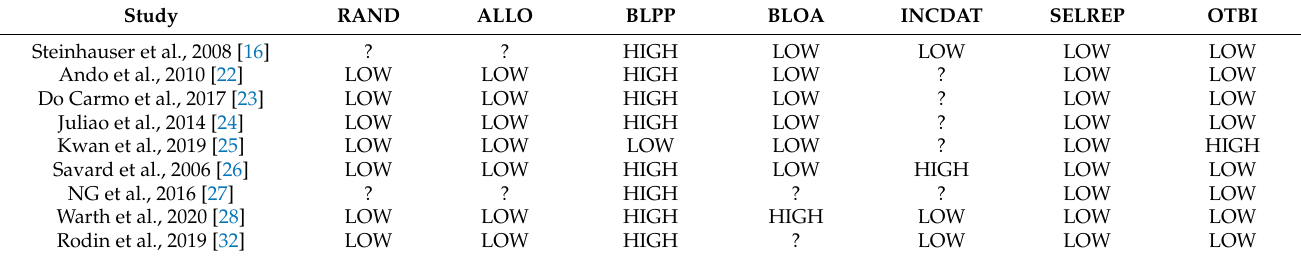
Table 1. Risk of bias assessment of included